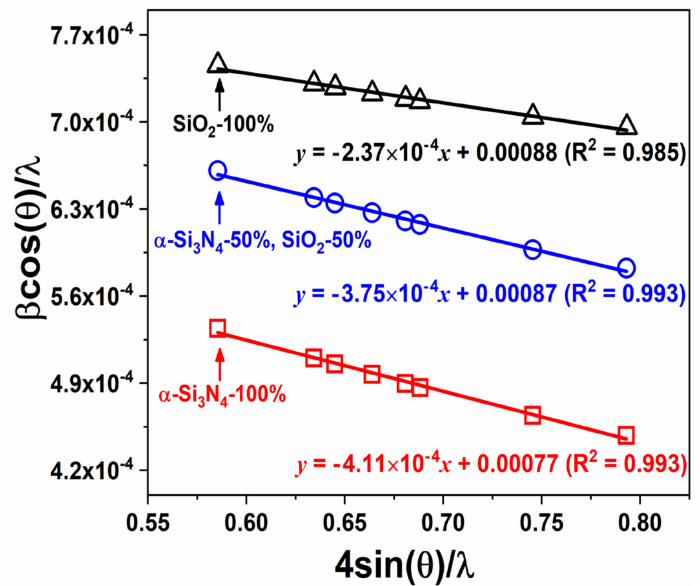
Figure 11. Williamson − Hall plots of BSON:Eu 2 +